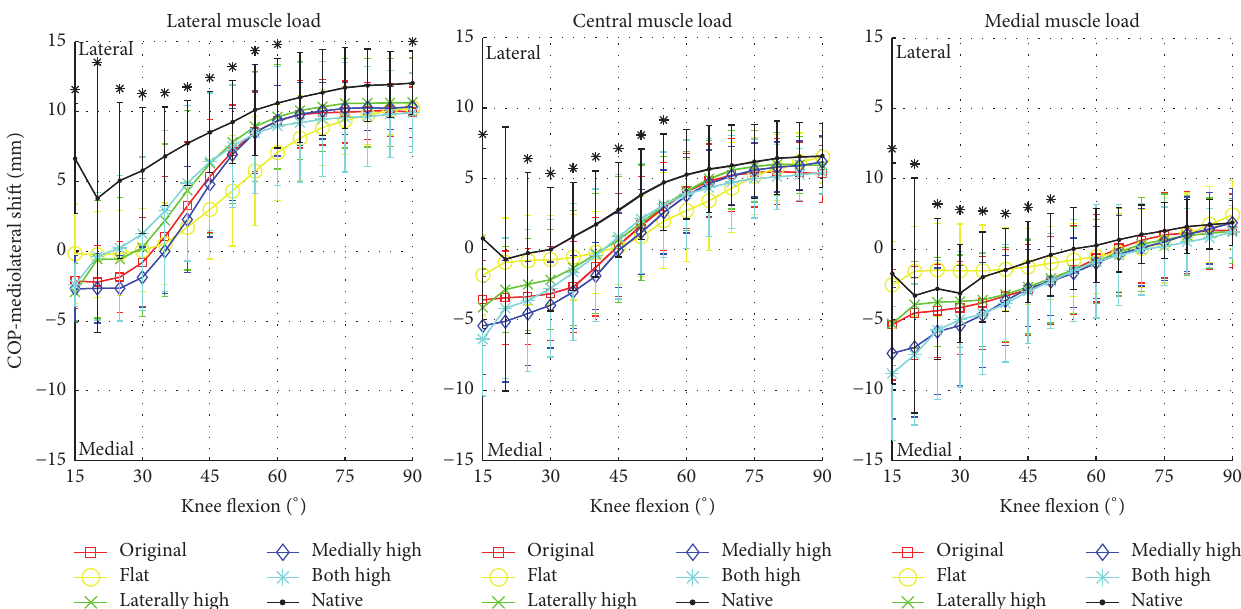
Figure 7: Medial and/or lateral displacement of the centre of pressure of the patella with increased lateral, central, and increased medial muscle load after implantation of the different design variations without patellar resurfacing (native, original, flat, laterally high, medially high, and both sides high) ( ∗ significant difference in